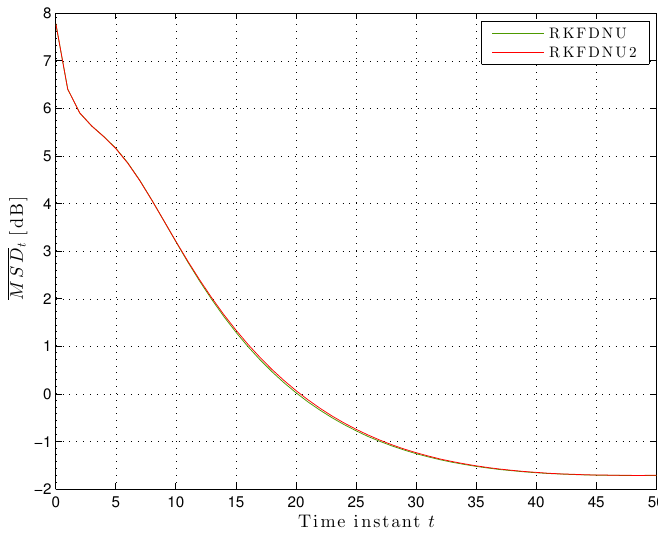
Figure 9. Least favorable mean square deviation across the network with tolerance c = 0.02.